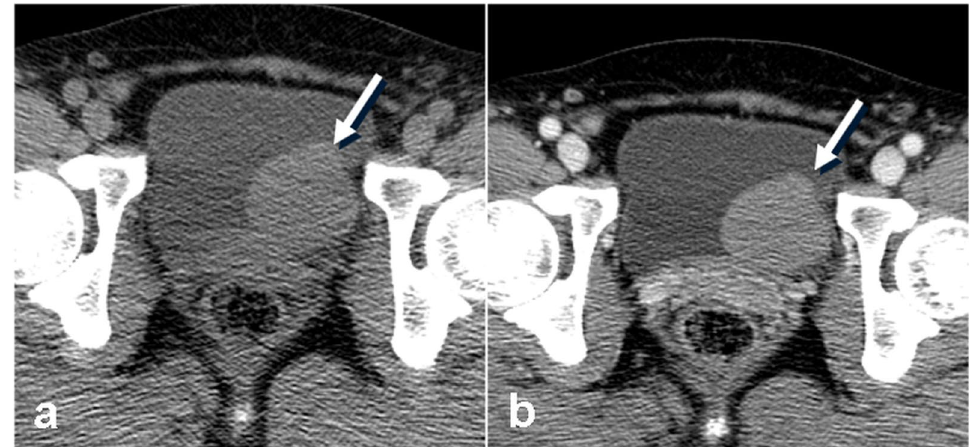
Fig. 7 A 57‑year‑old female patient with bladder leiomyoma. Axial non‑contrast a and contrast‑enhanced b CT images showing a smooth homogenous enhancing solid mural mass of the bladder (arrow), similar in appearance to uterine leiomyoma